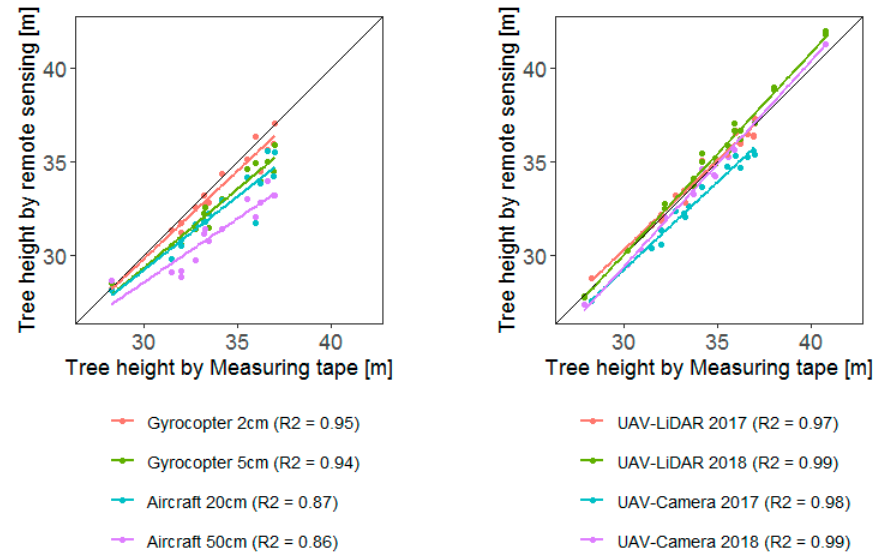
Figure 6. Regression analysis for the remote sensing datasets. Tree heights recorded via measuring tape were assumed as the real tree heights. Points represent individual measurements, the colored lines represent the regressions and the black line represents a 1:1 correlation.